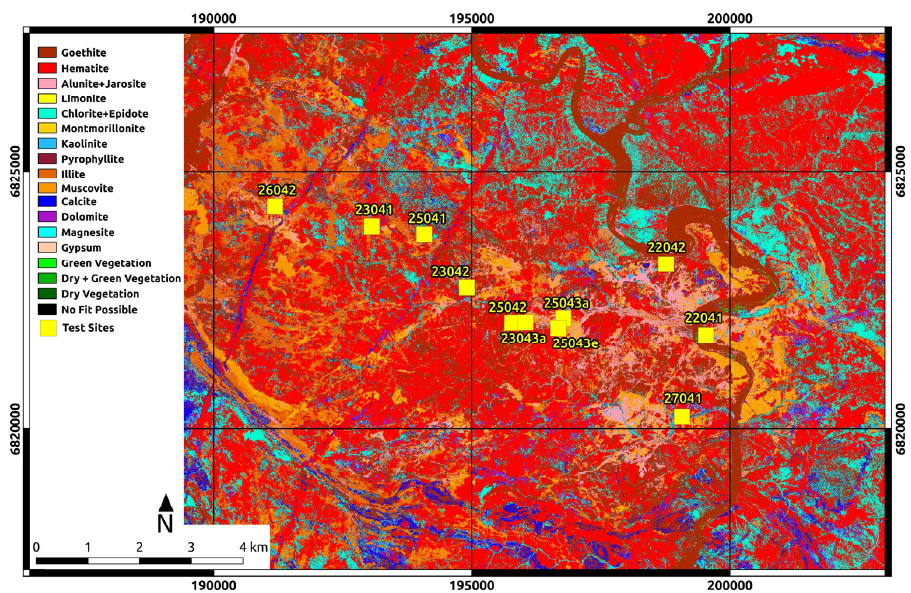
Figure 15. Best weighted fit material map of EnGeoMAP 2.0 calculated from airborne HyMAP data, which was used as simulation input to produce the EnMAP data.